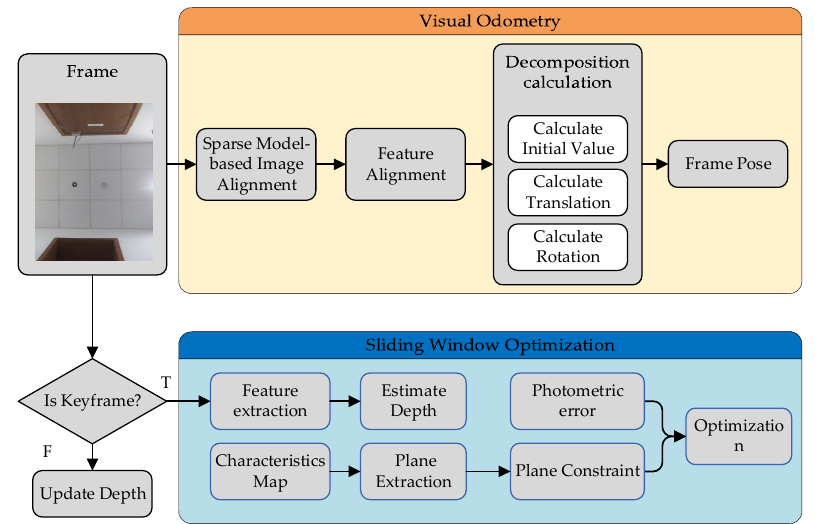
Figure 2. Framework overview of our proposed Struct-PL-SVO. The visual odometry part estimates the camera motion between frames, and the sliding window optimization part optimizes the local feature map with both the photometric error and the geometric constraint of coplanarity.